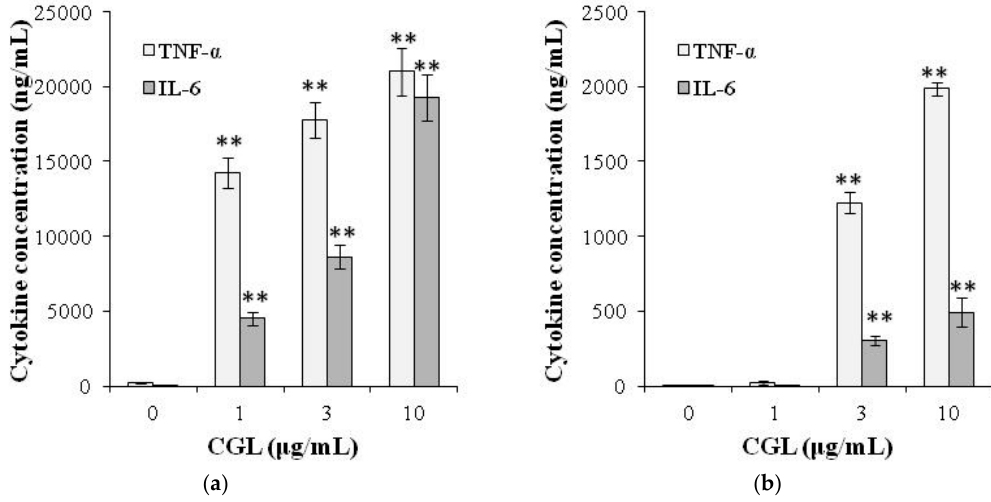
Figure 4. Production of cytokines induced by CGL in ( a ) mouse RAW264.7 and ( b ) human THP-1 macrophages. Cells were incubated for 24 h with or without lectin. The levels of cytokines in the culture medium were measured by ELISA. The ELISA data are expressed as mean ± SD of three separate experiments. ** indicates a significant di ff erence at the level of p < 0.001 compared to control cells. Figure was modified from